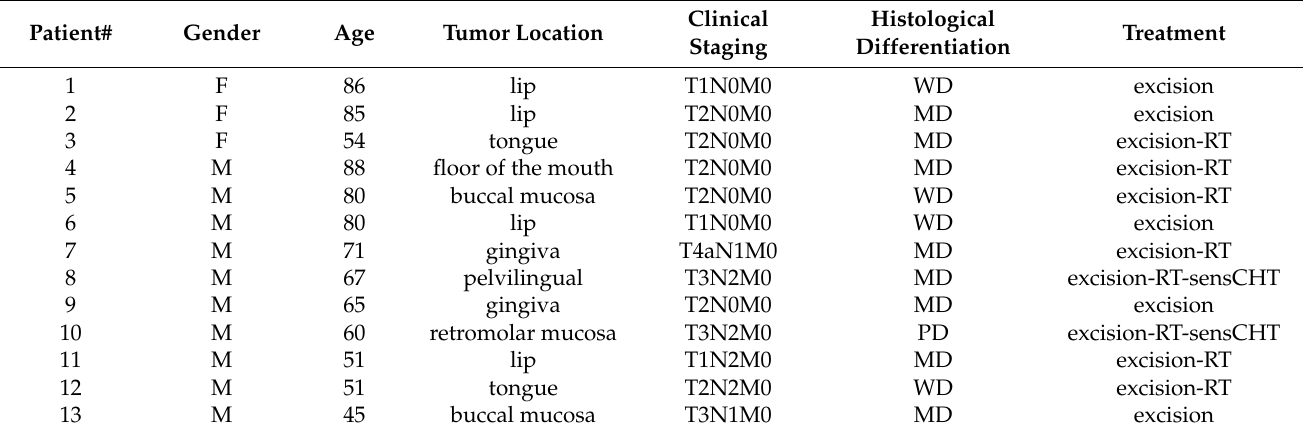
Table 2. Clinical and histopathological details of OSCC patients.